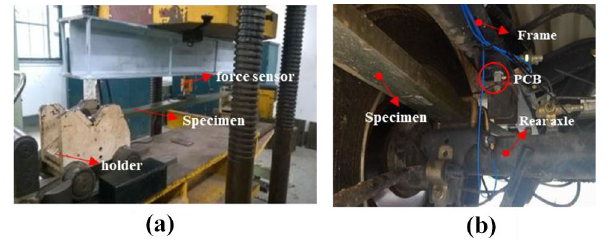
Figure 3. Mechanical property test of composite leaf spring; ( a ) the stiffness test; ( b ) the damping